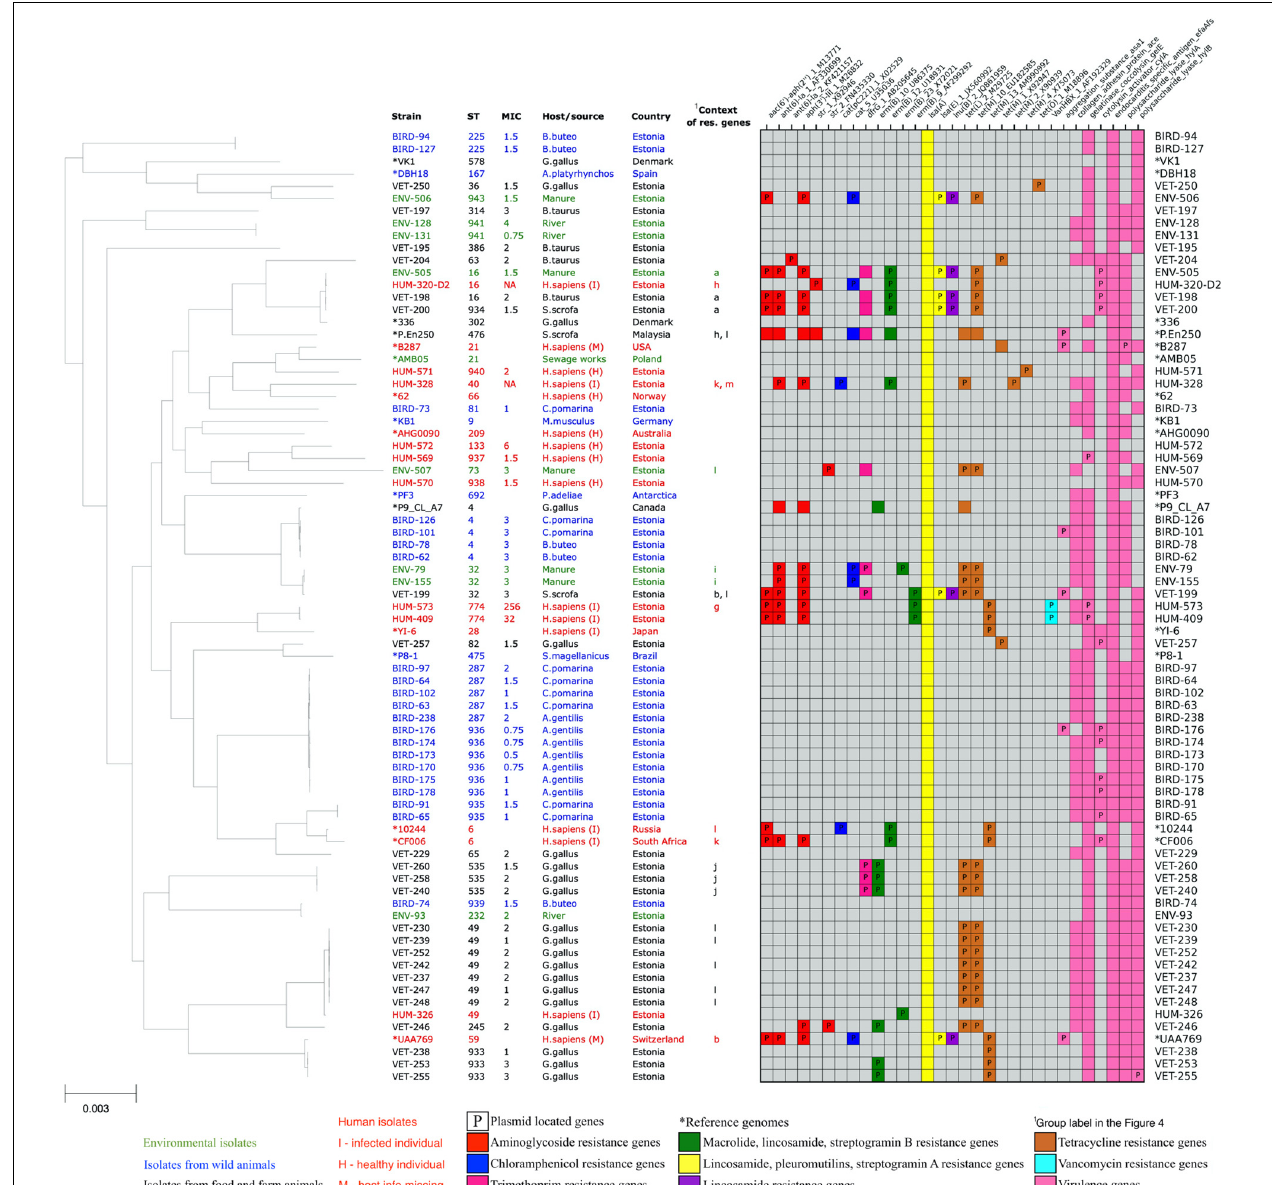
FIGURE 2 | Core-genome phylogenetic tree of our collected 61 Enterococcus faecium isolates and 16 reference genomes with the distribution matrix of the antimicrobial resistance and virulence genes detected in their whole-genome sequences.